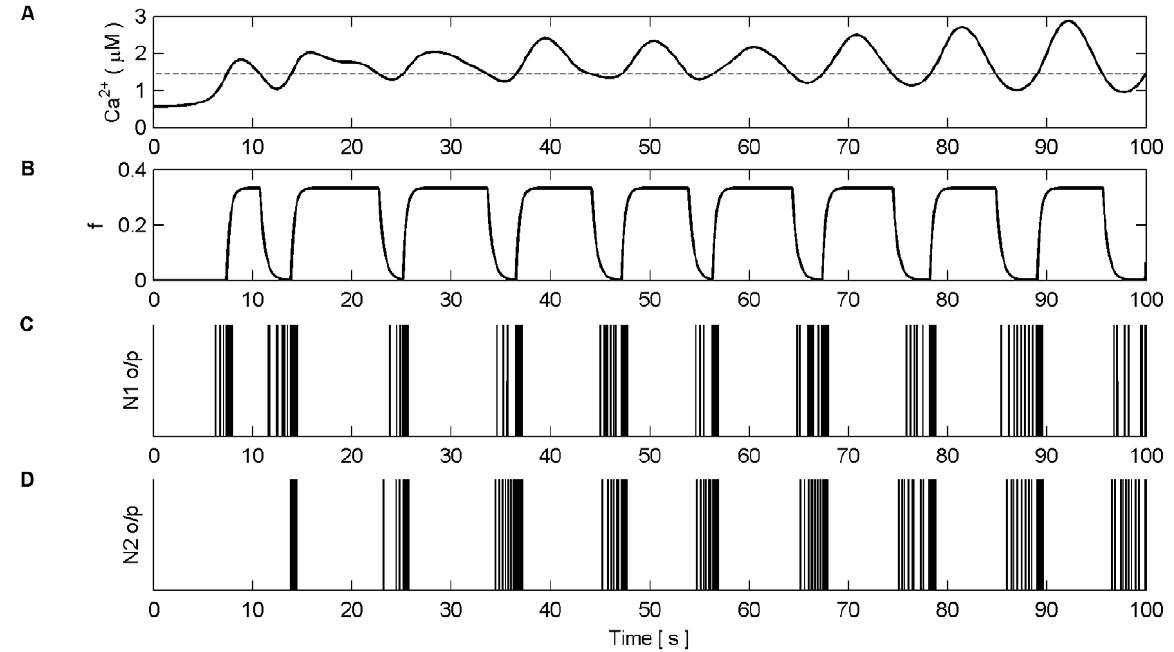
Figure 20. Total Ca 2 + oscillation and neural firing activity in the AM mode. (A) Total Ca 2 + oscillation and Ca 2 + threshold (dashed line). (B) f function. (C) Neural firing activity of N1. (D) Neural firing activity of N2. Note how total Ca 2 + is much more erratic up until , 40 s. As a result, the coordinated bursting of N1 and N2 during this time does not have a constant period. After , 40 s phase locking of the individual microdomains is achieved and the coordinated activity of N1 and N2 is more constant. Furthermore, the total Ca2 + oscillation once again becomes much more regular.